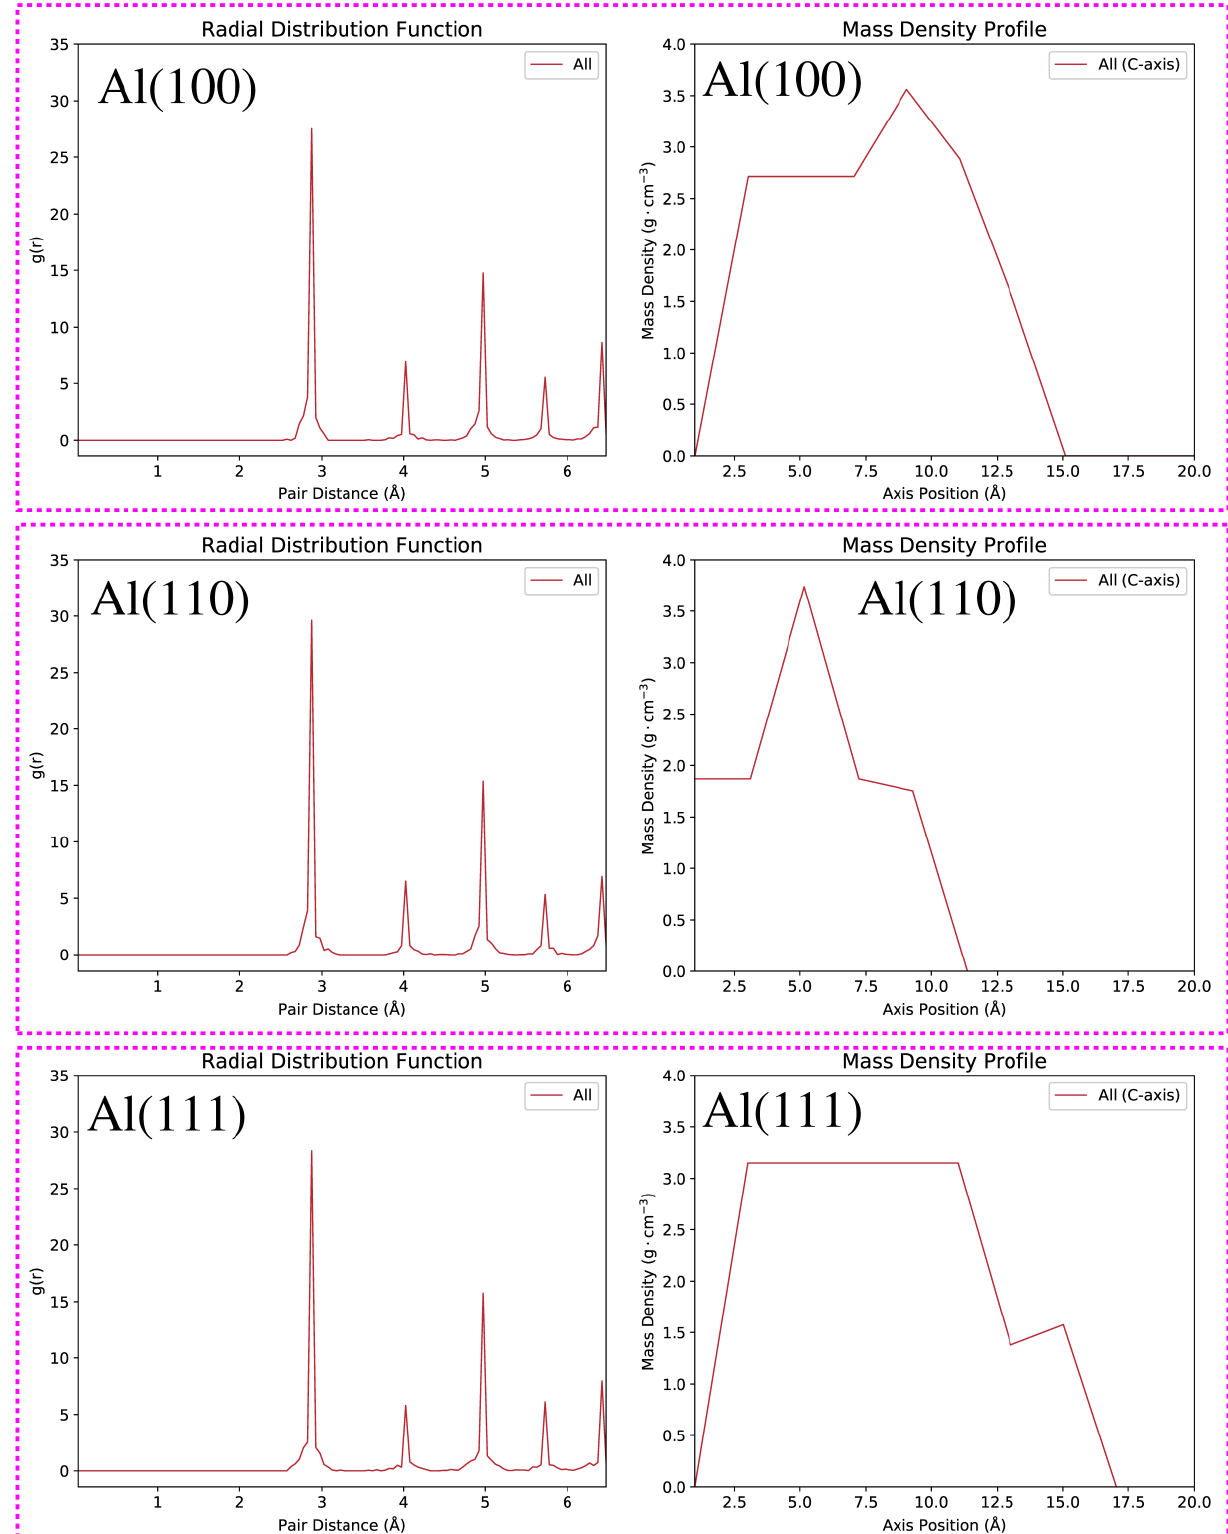
Figure 2. RDFs ( left panel) and mass density profiles ( right panel) of the reconstructed Al(100), Al(110), Al(111) slabs having a surface